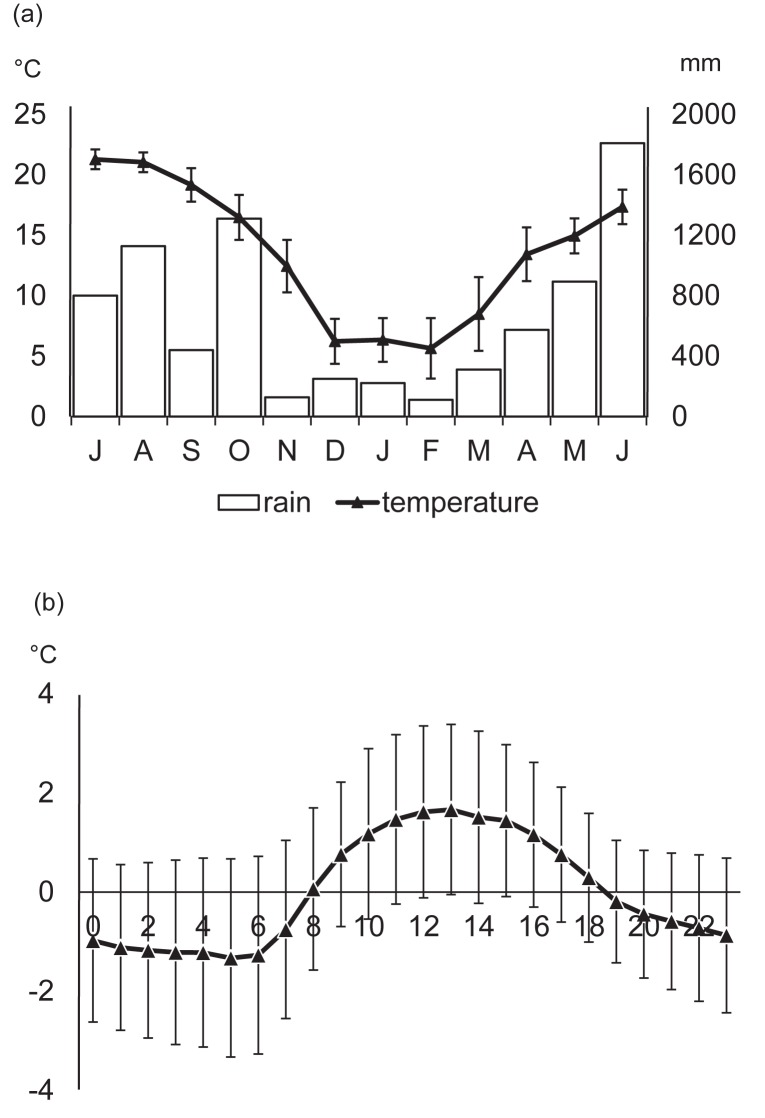
Meteorological record in the study site during the study period.(a) Monthly mean±SD of temperature and rainfall and (b) mean±SD in ambient temperature deviations from the mean temperature on that day. X axis is the time of day.